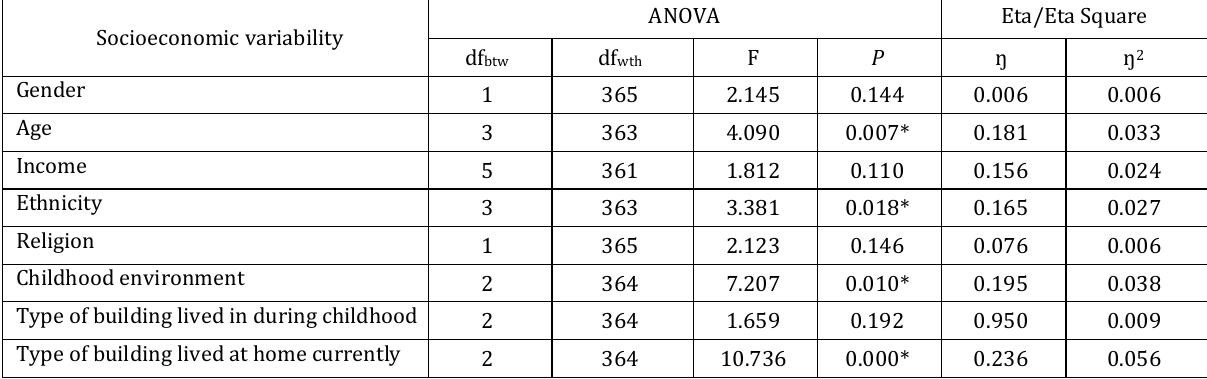
Table 10. Socioeconomic variability and coping ability with sanitary hazards (source: Authors’ fieldwork data analysis, 2016) Socioeconomic variability